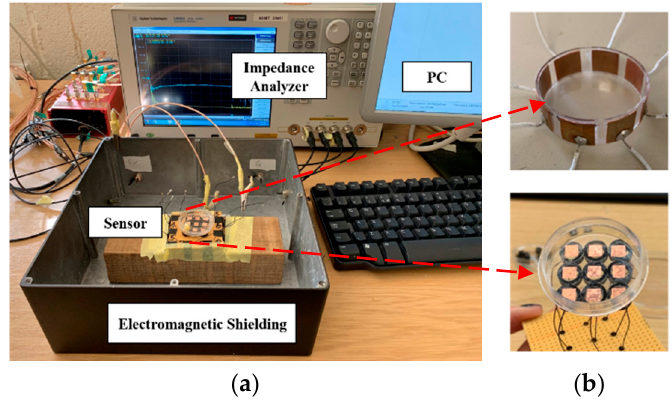
Figure 5. ( a ) Experimental setup. ( b ) Sensors in circular (top) and planar array